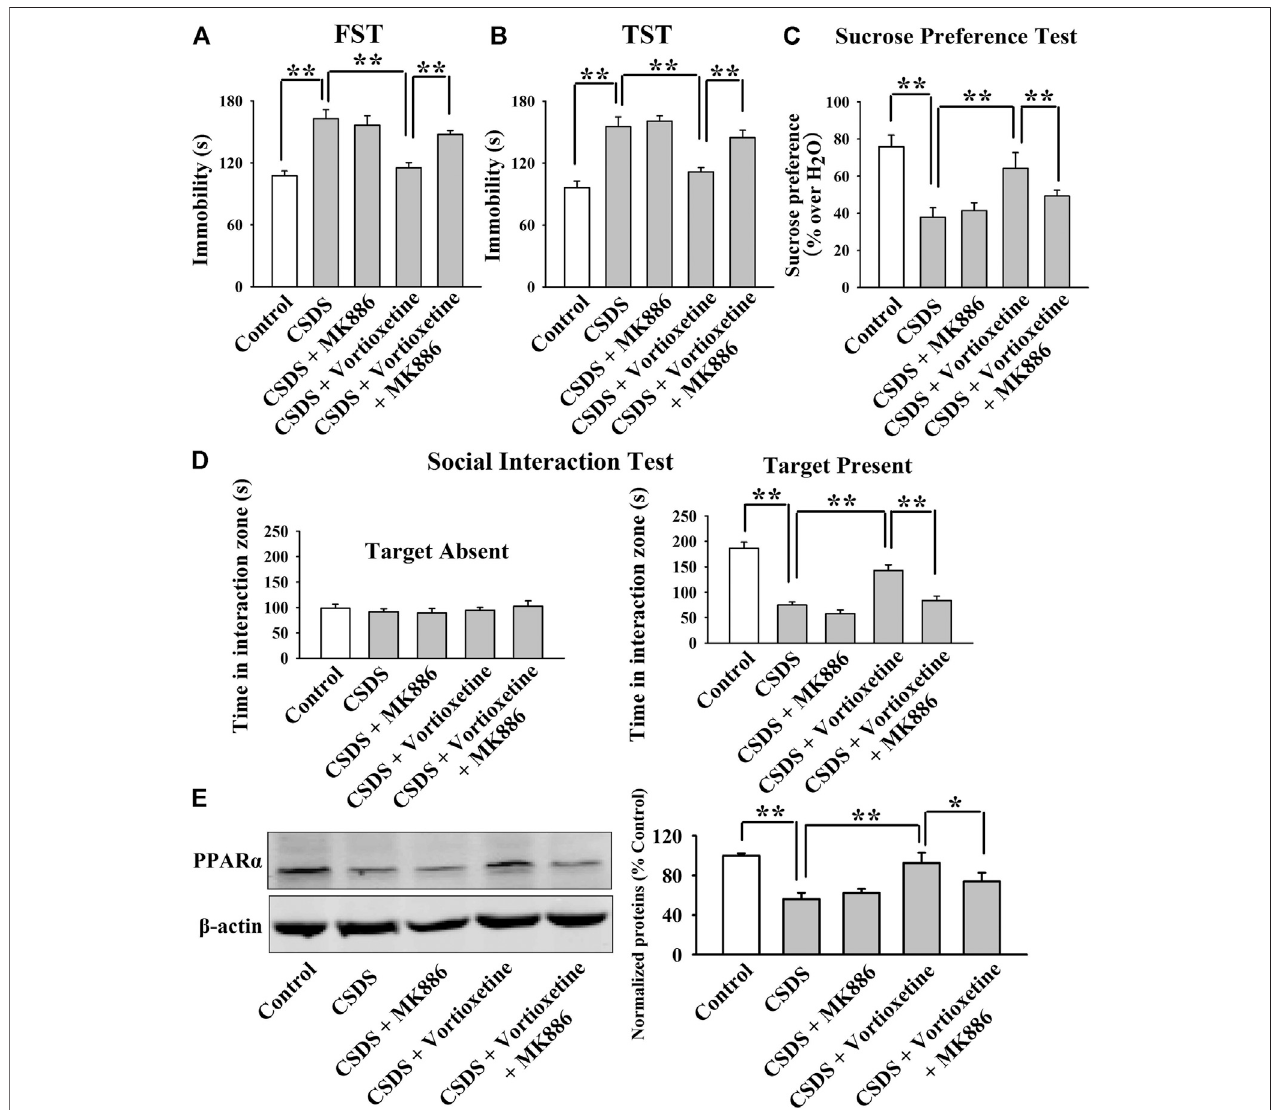
FIGURE 6 | The antidepressant effects of vortioxetine in the CSDS model were signi fi cantly prevented by MK886 co-treatment. (A – D) The reversal effects of vortioxetine on the CSDS-induced depressive-like behaviors in mice were signi fi cantly prevented by MK886 co-treatment, as indicated by the FST, TST, sucrose preference test and social interaction test. (E) Representative images and quantitative analyses show that the use of MK886 notably blocked the enhancing effects of vortioxetine on the hippocampal PPAR α expression in the CSDS-exposed mice. For (A – D) , n (cid:2) 10 per group; For (E) , n (cid:2) 5 per group. The data are expressed as the means ± S.E.M.; * p < 0.05, ** p < 0.01. The comparisons were made by two-way ANOVA followed by Bonferroni ’ s test.